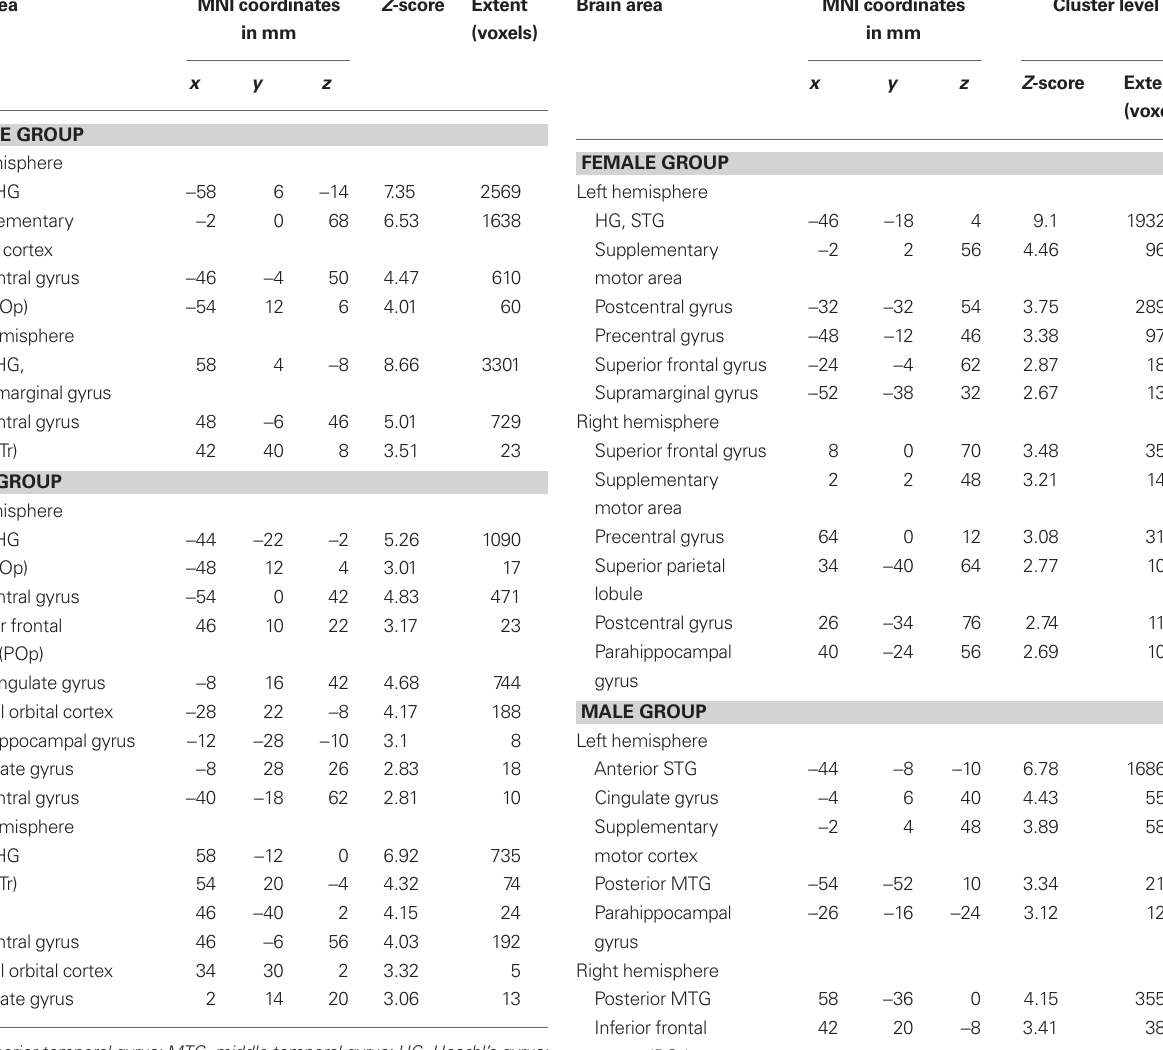
Table 2 | Mean coordinates (mm) of the areas activated for the contrast melody discrimination minus auditory control for the female group and for the male group ( z -score > 2.3, cluster-corrected threshold of p < 0.05).